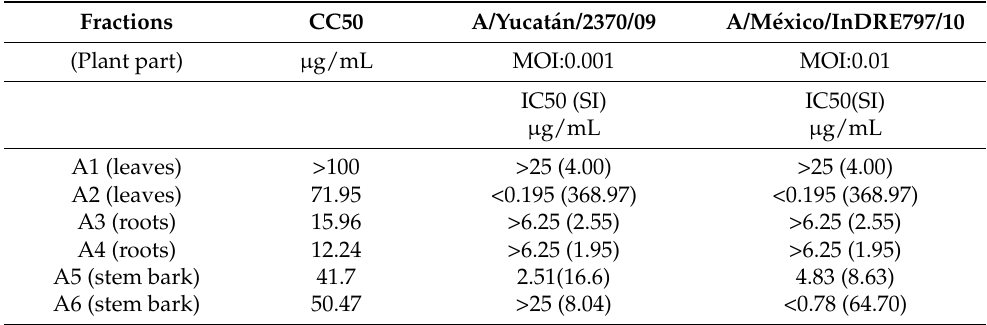
Table 1. Cytotoxic and antiviral activity of fractions A1 to A6 from E. yucatanensis during co-treatment assays.